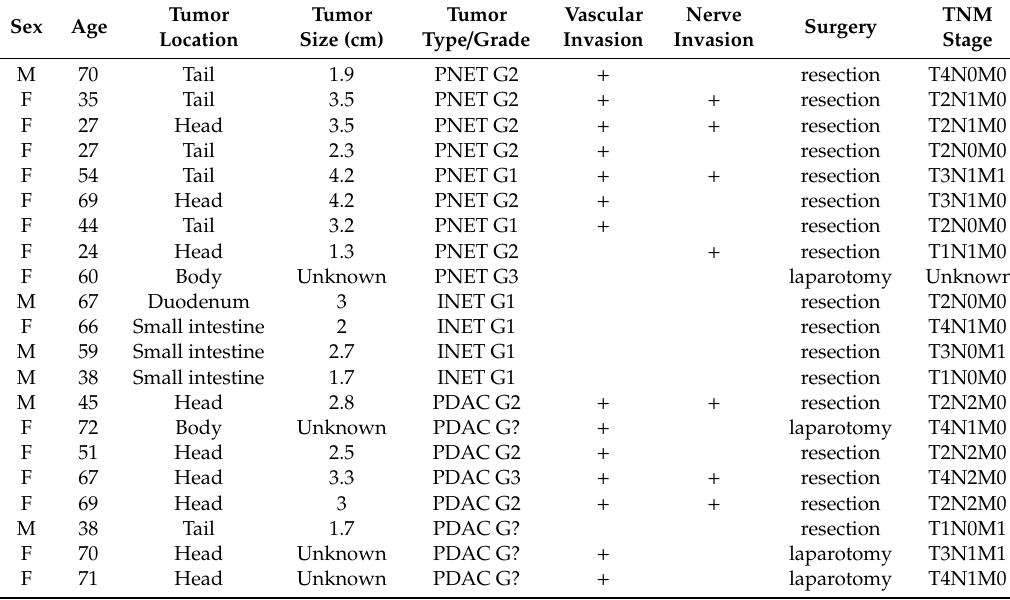
Table 1. Detailed characteristics of the